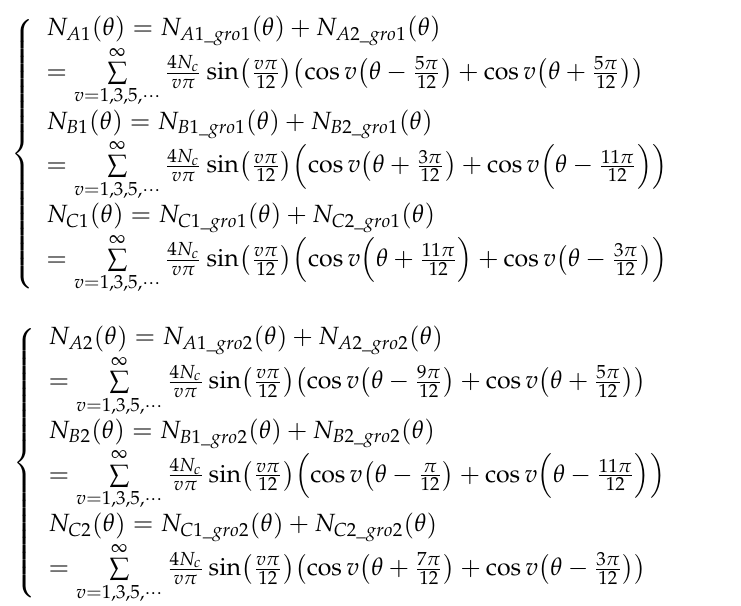
Figure 10. DTP-FL winding with 12-slot/10-pole combination. ( a ) Star graph, ( b ) winding layout. Winding MMF is analyzed with winding function method. Winding functions N A 1 ( θ ), N B 1 ( θ ), N C 1 ( θ ), N A 2 ( θ ), N B 2 ( θ ), N C 2 ( θ ) of two groups of three phase are given as (6), (7). Winding function curves of DTP-FL winding are shown in Figures 11 and